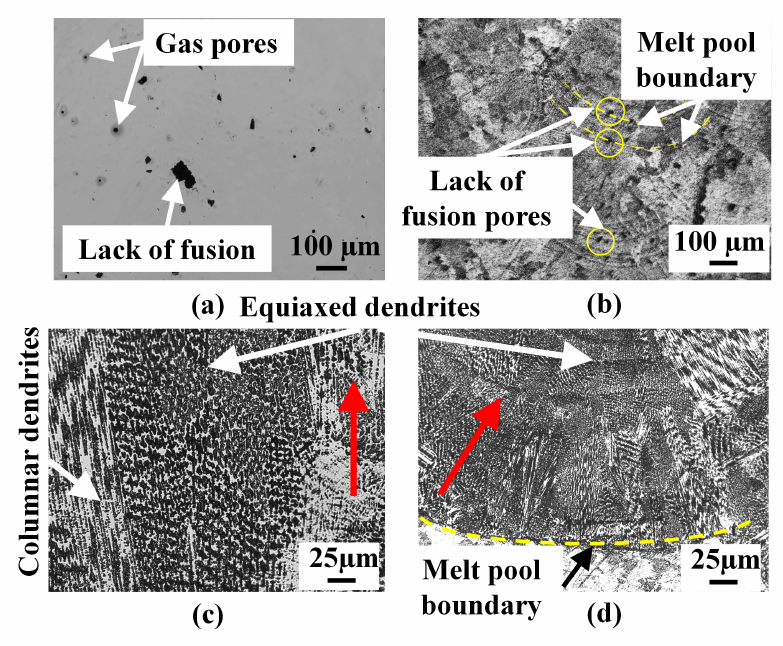
Figure 7. ( a ) OM image highlighting gas and lack of fusion pores. ( b ) Etched OM images of the powder-fed L-DED specimen highlighting the melt pool boundaries and lack of fusion pores. Microstructure revealing both columnar and equiaxed dendrites: ( c ) at the middle of the specimen and ( d ) in the melt pool of the first layer near the substrate. The vertical red arrow in ( c ) indicates the build direction. The red arrow in ( d ) represents the growth direction of the columnar